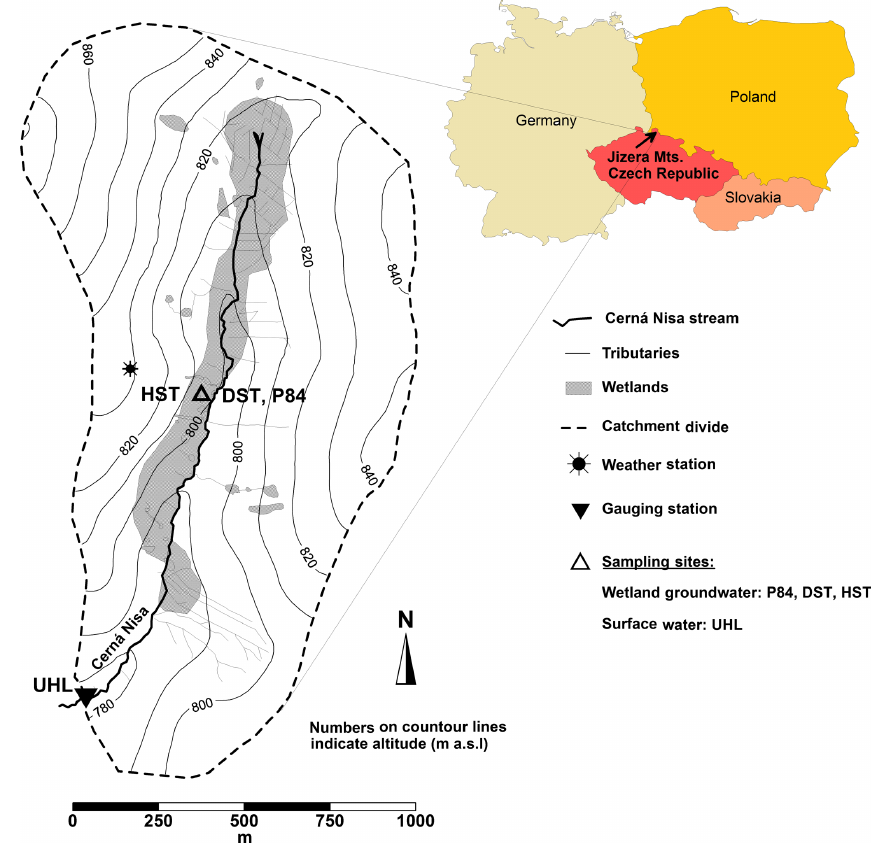
Figure 1. Location of the Uhlíˇrská catchment and sampling sites modified from Sanda et al. (2014).